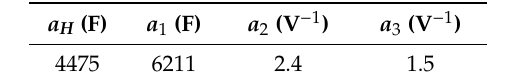
Table 1. The identified parameters of the modified Stern